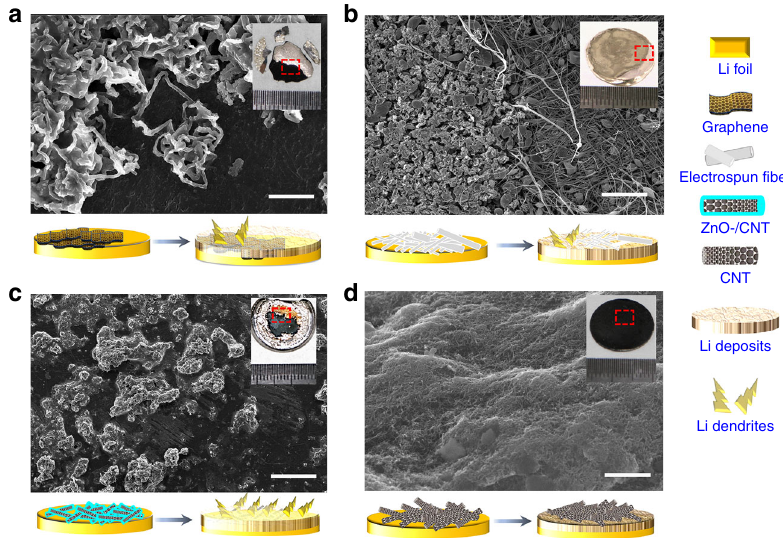
Fig. 4 SEM images of top view morphology of the interfacial layer-coated Li foils after extended stripping and plating. Li foil symmetric cells coated with a graphene, b electrospun fi ber, c ZnO/CNT, and d CNT, cycled at 1 mA cm – 2 with a capacity of 1 mAh cm − 2 after ( a ) 210, b 180, c 280, and d 520 cycles. The insets show digital photographs of the corresponding Li foils with interfacial layers after testing. The schematics under each fi gure show the Li deposition/dendrite growth process. Scale bar, 20 μ m for a , 5 μ m for b , 200 μ m for c , and 2 μ m for